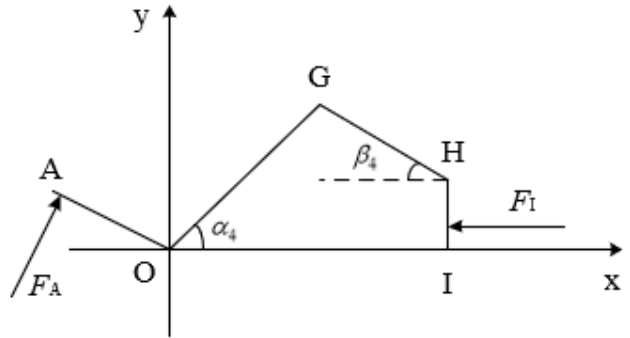
Figure 11. Force analysis of clamping unit.